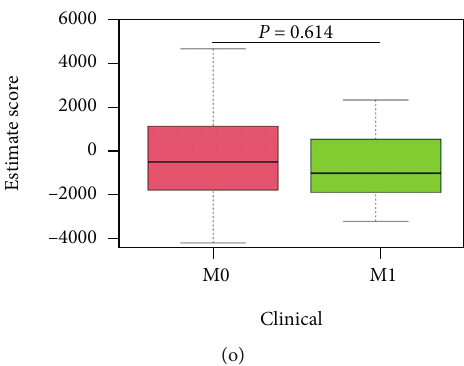
Figure 2: Correlation analysis of immune score and stromal score with survival and clinicopathological characteristics in bladder cancer cases. (a – c) Kaplan-Meier survival analysis of bladder cancer cases by comparing them with the median to determine high and low scores in immune score, stromal score, and estimate score, which was tested by the log-rank test. (d – f) Distribution of immune score, stromal score, and estimate score at di ff erent stages of cancer, which was tested by the Kruskal-Wallis rank-sum test. (g – i) Distribution of the three scores in T staging, which was tested by the Kruskal-Wallis rank-sum test. (j – l) Distribution of the three scores in N staging, which was tested by the Kruskal-Wallis rank-sum test. (m – o) Distribution of the three scores in M staging, which was tested by the Wilcoxon rank-sum